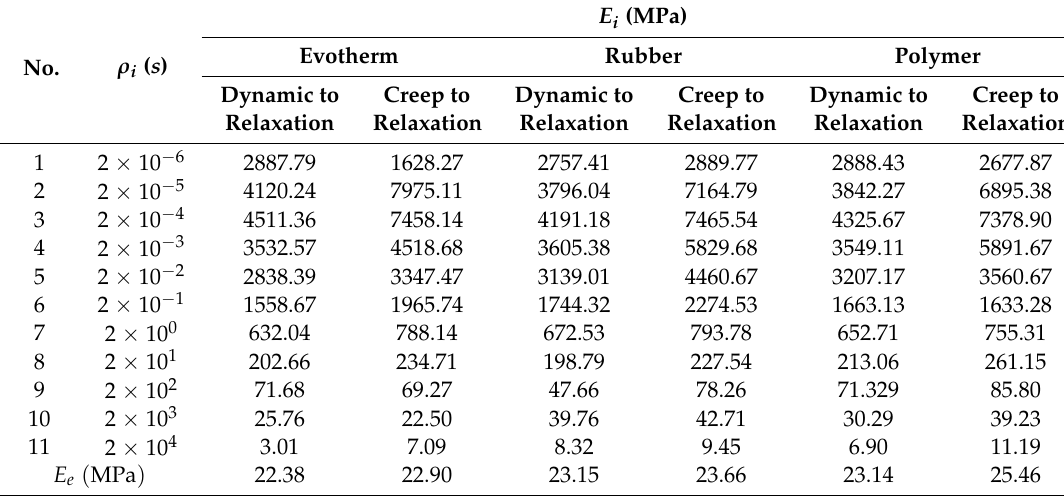
Table 4. Prony Series Coefficients of Relaxation Modulus Obtained from Dynamic Modulus and Creep Compliance for new data points from previous